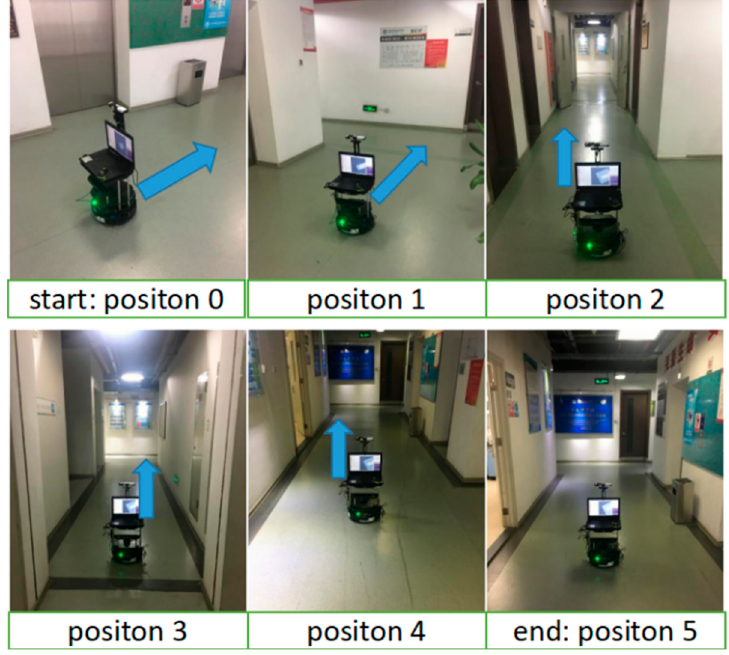
Figure 8. The marked positions of the robot.